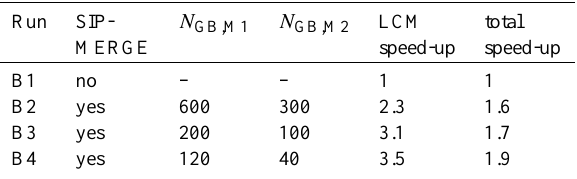
Table 4. List of simulations in Fig. 4.2 investigating the SIP- MERGE operation. See text for description of parameters N GB,M1 and N GB,M2 . The run B4 has one additional SIPMERGE operation with N GB,M1 = 80 and N GB,M2 = 0 which is executed 500s after the updraught came to a halt. LCM speed-up and total speed-up measure by which factor the execution time of the LCM module and the full model (dynamics + microphysics)